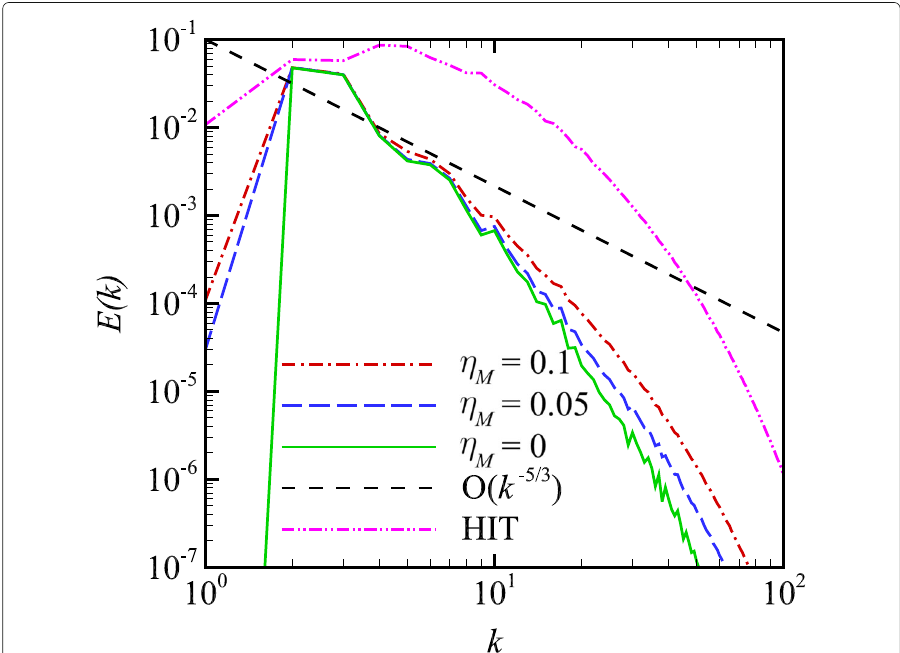
Fig. 2 Spectra of the HIT disturbance and the initial flow fields in cases M0, M1, and